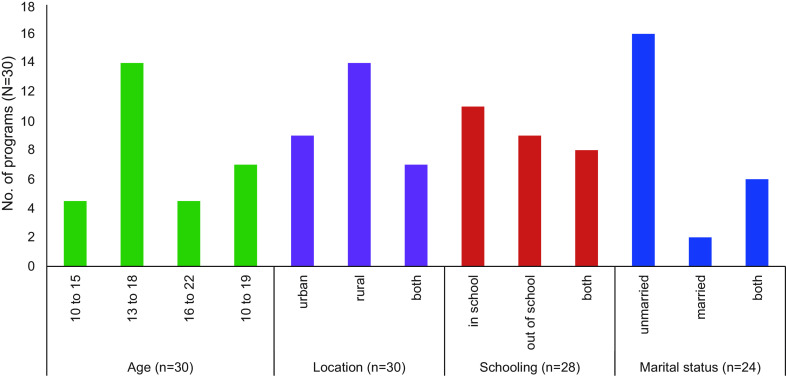
Frequency of Participants’ Features in Community-Based Girl Group Programs